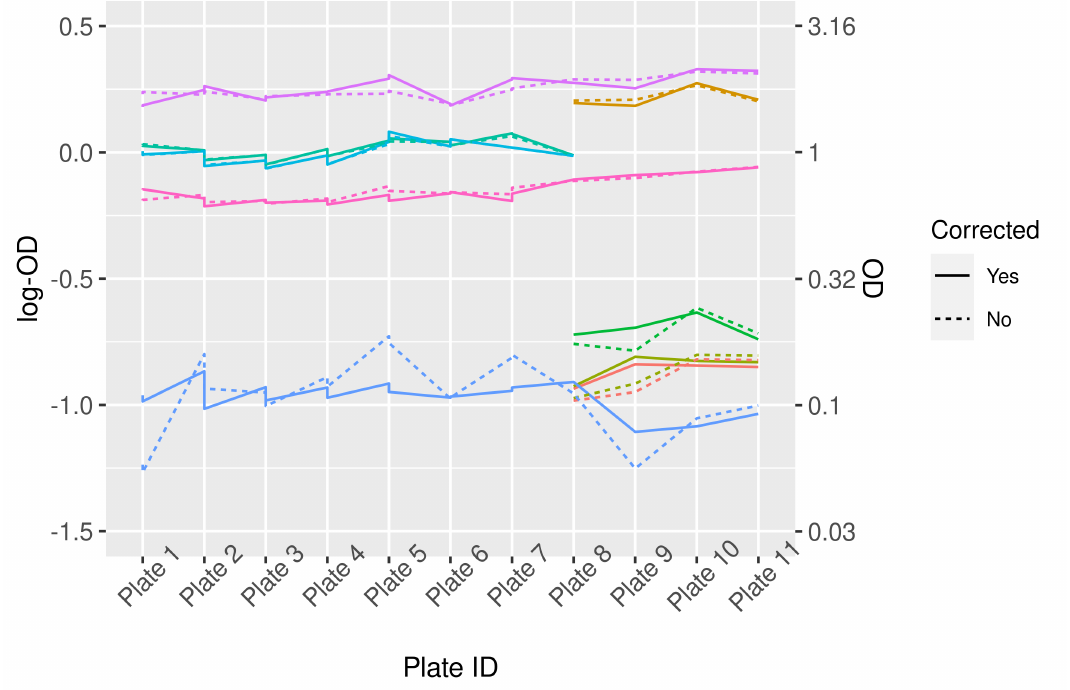
Figure 1. LogOD and OD values for control sera before and after correction for plate-to-plate variation. Different colors represent different control sera. Note that not all controls were present on each plate, therefore some lines do not cover the complete width of the